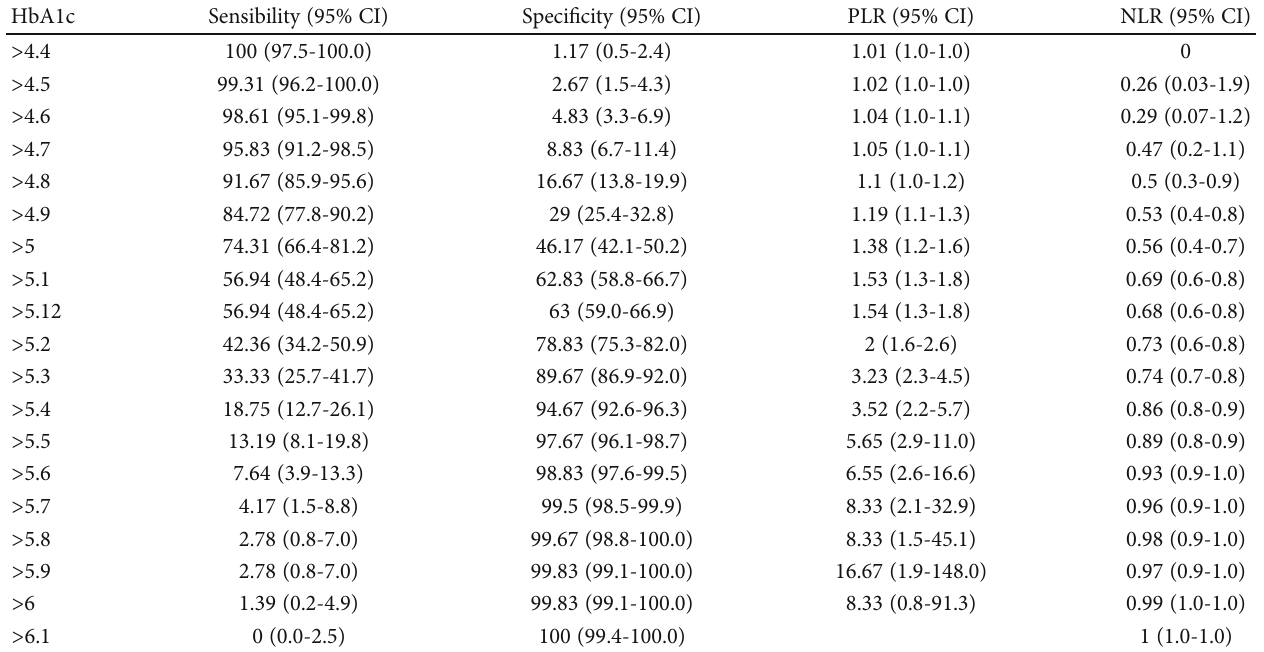
Table 3: ROC curve values of fi rst-trimester Hba1c in the diagnosis of GDM.